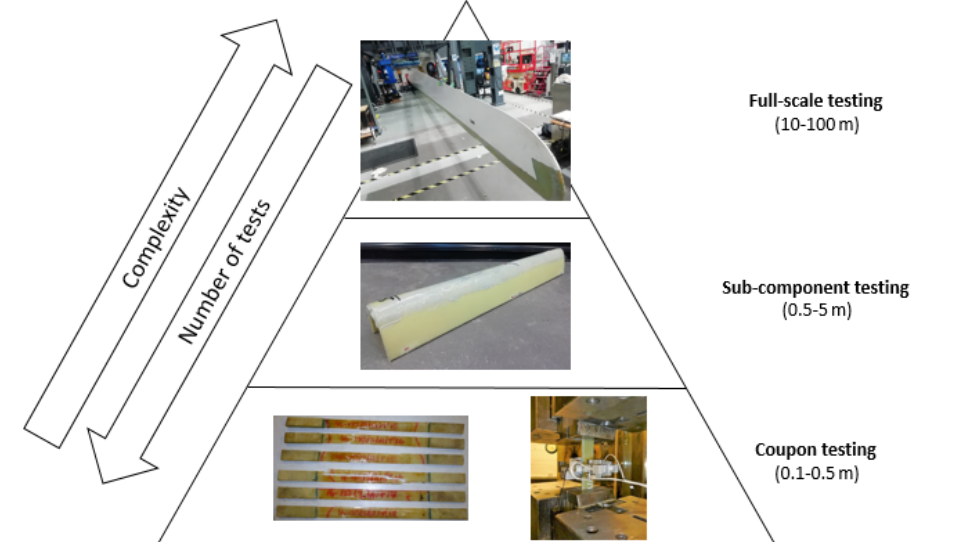
Figure 1. Test pyramid methodology for the development of a new wind turbine blade component that is used in this study.